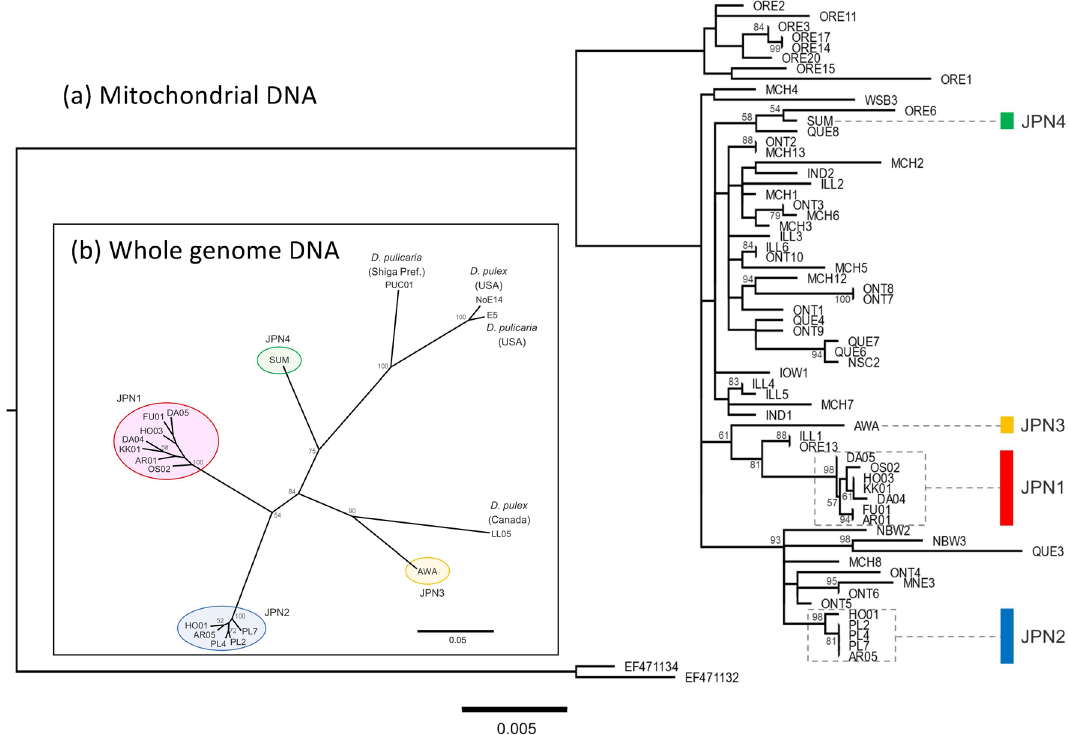
Figure 1. Phylogenetic relationships of the Daphnia pulex lineages in Japan. ( a ) Phylogenetic tree of the panarctic D. pulex group based on a combined dataset of mitochondrial ND5 and the control region (1747 nucleotide sites including indel). Numbers on branches indicate bootstrap values (> 50 are shown). The analysis included the following samples: seven genotypes in JPN1 (AR01, DA04, DA05, FU01, HO03, KK01, and OS02), five genotypes in JPN2 (AR05, HO01, PL2, P4, and PL7), one genotype in JPN3 (AWA), one genotype in JPN4 (SUM), and genotypes belonging to the North American group described by Paland et al. 21 . Polar Daphnia pulicaria (EF471134 and EF471132) were employed as outgroups. ( b ) Phylogenetic tree of Daphnia pulex in Japan and other lineages. The tree was constructed based on 5883 SNPs from whole-genome sequence